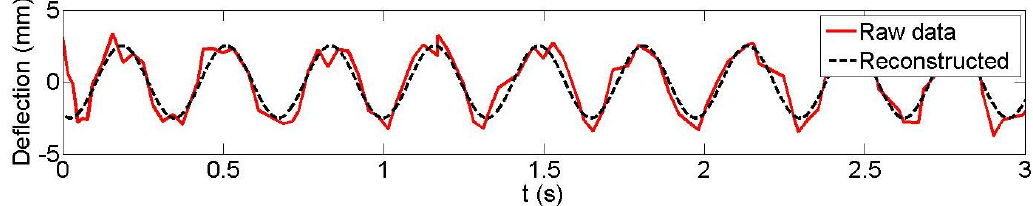
Figure 10. Kinect observed and reconstructed vertical displacements ( = 3 Hz), dataset 5 witness plate 7.